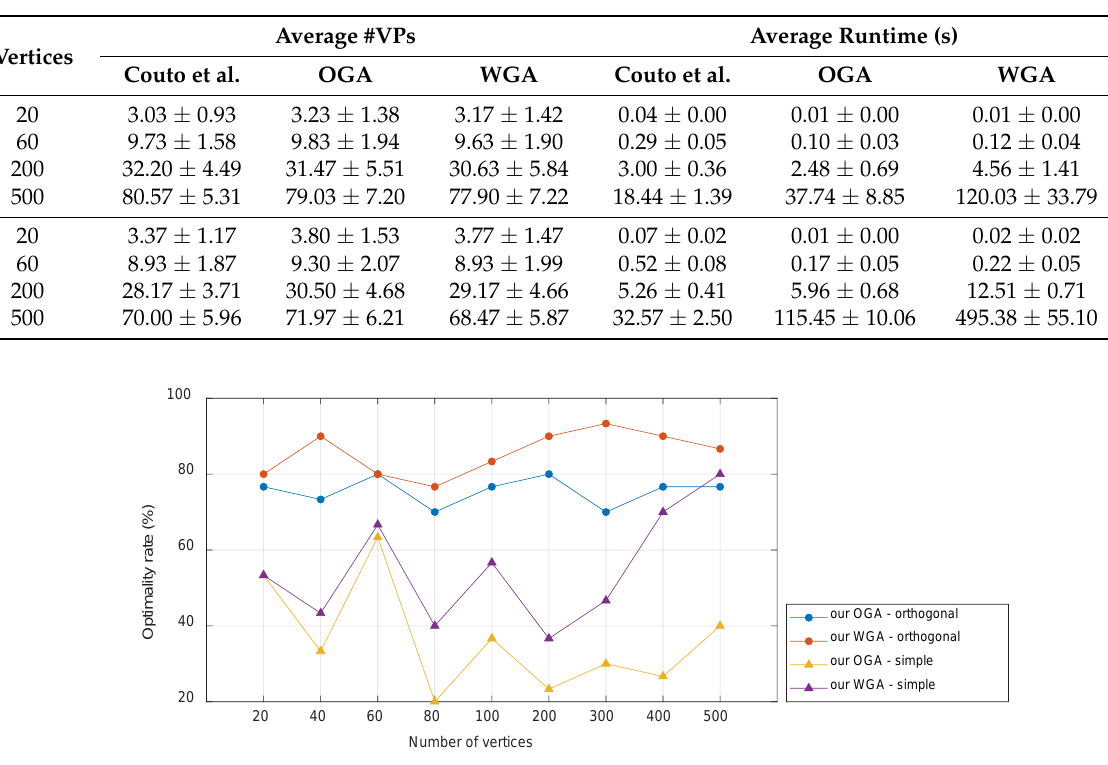
Table 4. Summary of the numerical results.